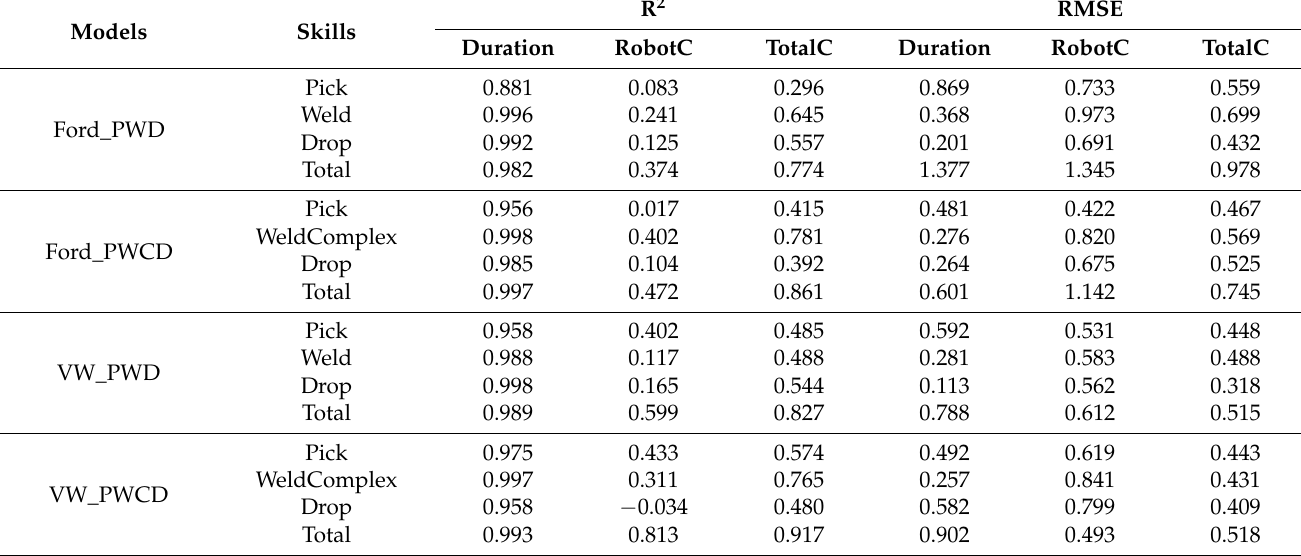
Table 1. Model Evaluation: summary of R 2 and RMSE metrics calculated for the Duration, Robot Consumption (RobotC) and Total Consumption (TotalC) parameters for the four predictive models (Ford_PWD, Ford_PWCD, VW_PWD and